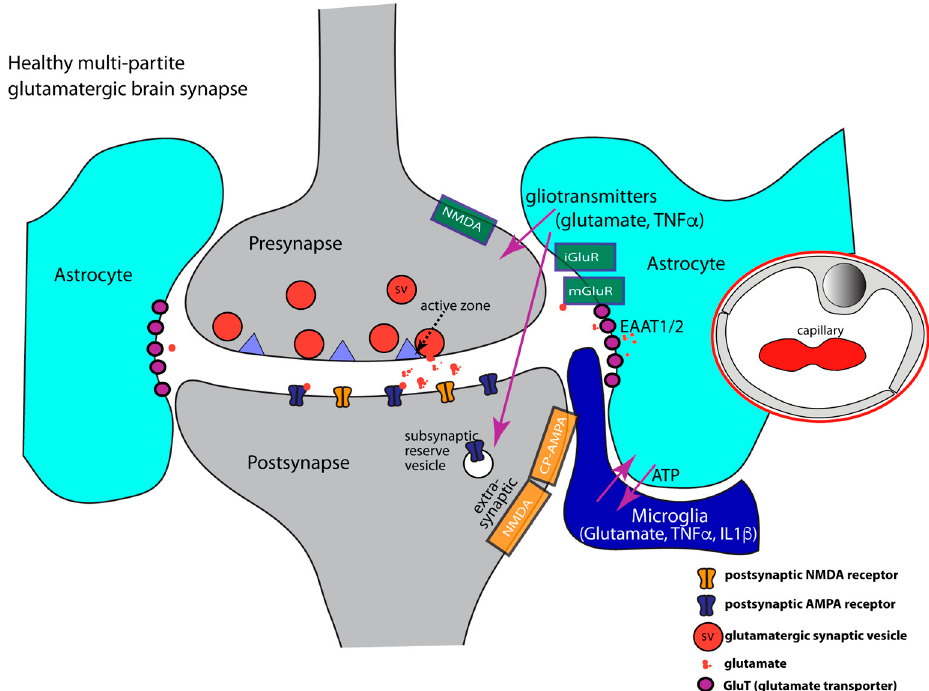
Figure 1. Glutamatergic brain synapses. It schematically depicts the composition of a healthy, glutamatergic tetrapartite brain synapse consisting of pre- and postsynaptic terminals and perisynaptic processes of astrocytes and microglia. At the presynaptic terminal, synaptic communication occurs via exocytosis of glutamatergic synaptic vesicles at the active zone. The active zone is a protein-rich compartment at which the synaptic vesicle fusion machinery is linked by active zone proteins close to voltage-gated Cav-channels. Influx of Ca 2+ through Cav-channels triggers exocytosis. The postsynaptic membrane contains ionotropic glutamate receptors. AMPA and NMDA receptors are depicted. Perisynaptic processes of astrocytes contain glutamate transporters that remove synapti- cally released glutamate to prevent spillover of glutamate to neighboring synapses. Perisynaptic processes from astrocytes communicate with microglia processes (magenta arrows). Astrocytes